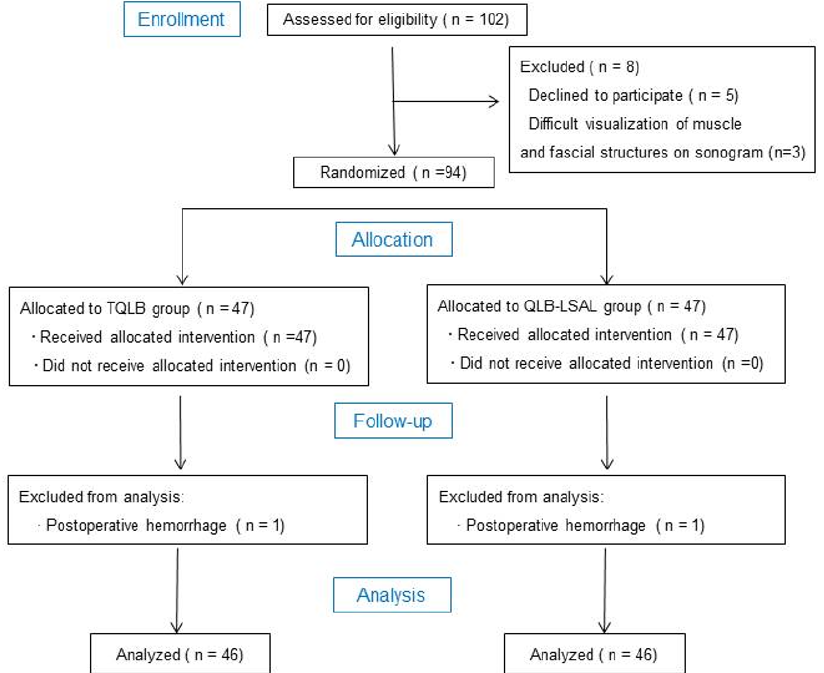
Figure 1. CONSORT study design. CONSORT, Consolidated Standards of Reporting Trials; TQLB, transmuscular quadratus lumborum block; QLB-LSAL, quadratus lumborum block at the lateral supra-arcuate ligament.